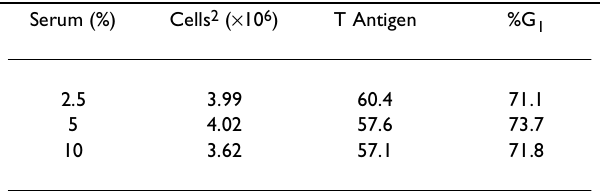
Table 2: Effect of serum on Tag and %G 11 .